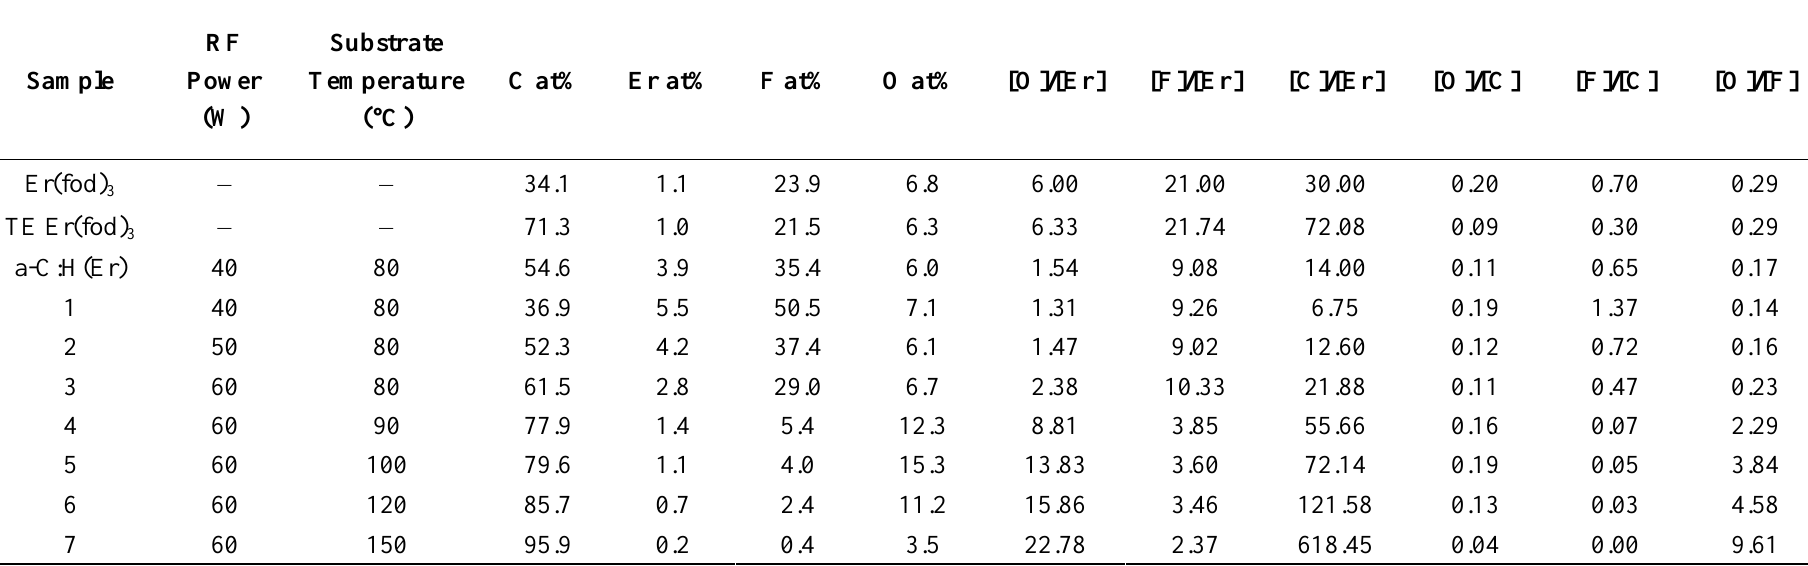
Table 1. Ratios of atomic concentrations and relative/absolute atomic concentrations of relevant elements in as-received stoichiometric Er(fod) compound, thermally evaporated (TE) Er(fod) , and in seven a-C:D(Er) films deposited under varying conditions as determined from 3 XPS